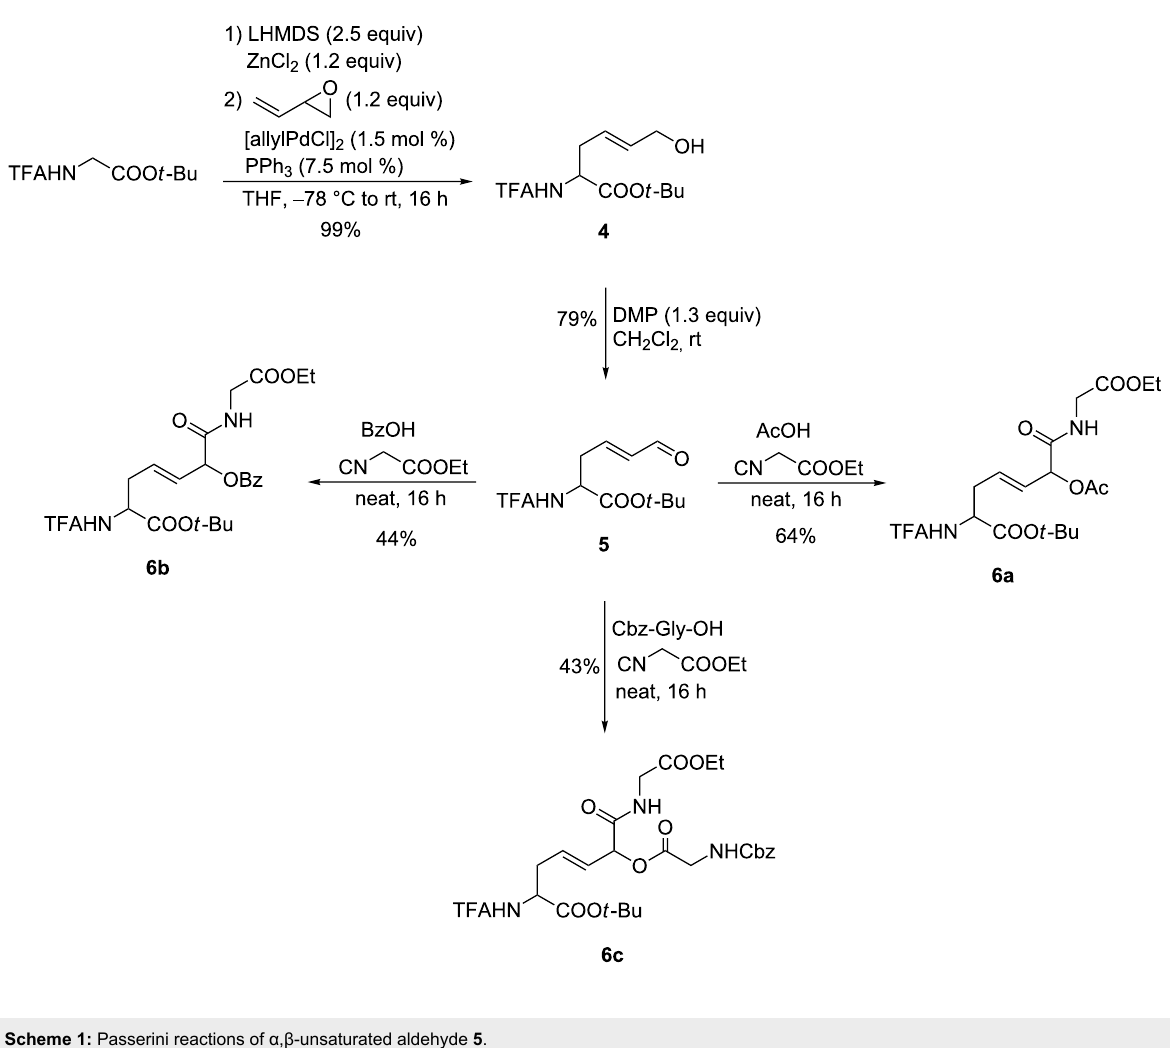
Scheme 1: Passerini reactions of α , β -unsaturated aldehyde 5